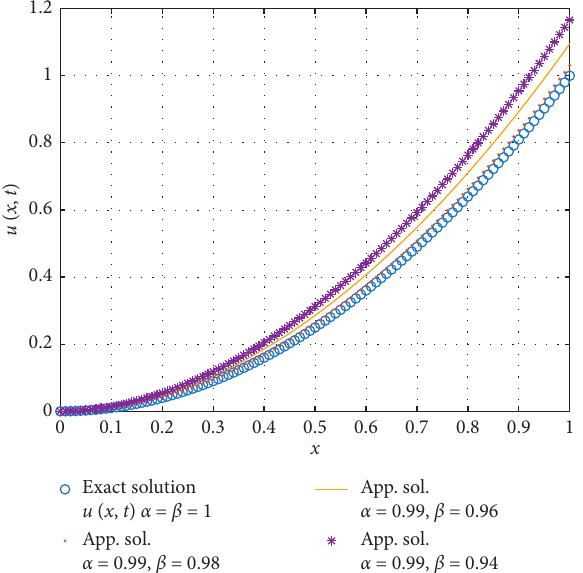
Figure 2: The exact and approximate solutions of u ( x,t ) , for Example 3, when we take different values of fractional order β and α � 0 . 99.